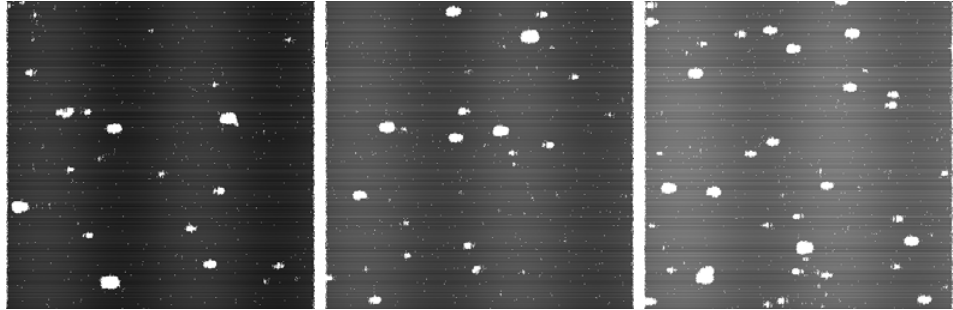
Figure 9. Figure 8 ′ s outlier is marked during filter processing.